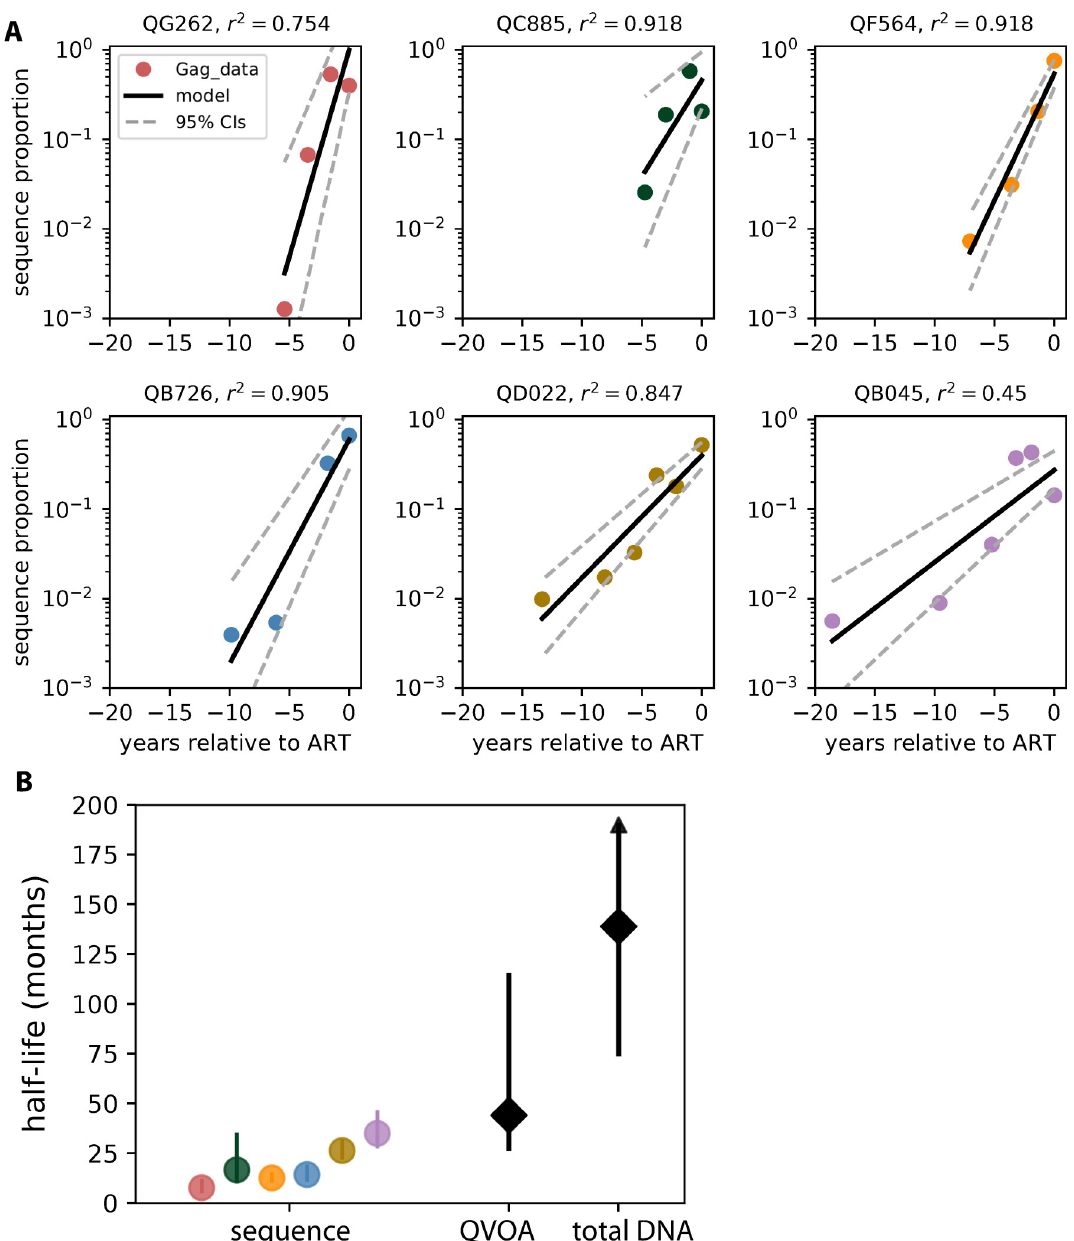
Fig 6. Quantifying gag sequence clearance half-life. (A) Log-linear regression plots of relative sequence abundance show an approximately exponential clearance of sequences over time during untreated infection in each of the 6 subjects. (B) Observed total HIV gag DNA pre-ART sequence half-lives for each individual based on the log-linear regression are shown: circles (colors by subject as in A) indicate the median estimated half-life and lines show 95% confidence intervals (CIs) associated with each estimate. These are compared to previously reported on-ART reservoir population size half-lives based on replication-competent reservoir decay measured by QVOA [8] and total HIV DNA decay [10]: black diamonds indicate the median estimated half-life and lines show 95% CIs associated with each estimate. Arrows indicate a CI that is inclusive of an infinite half-life (no